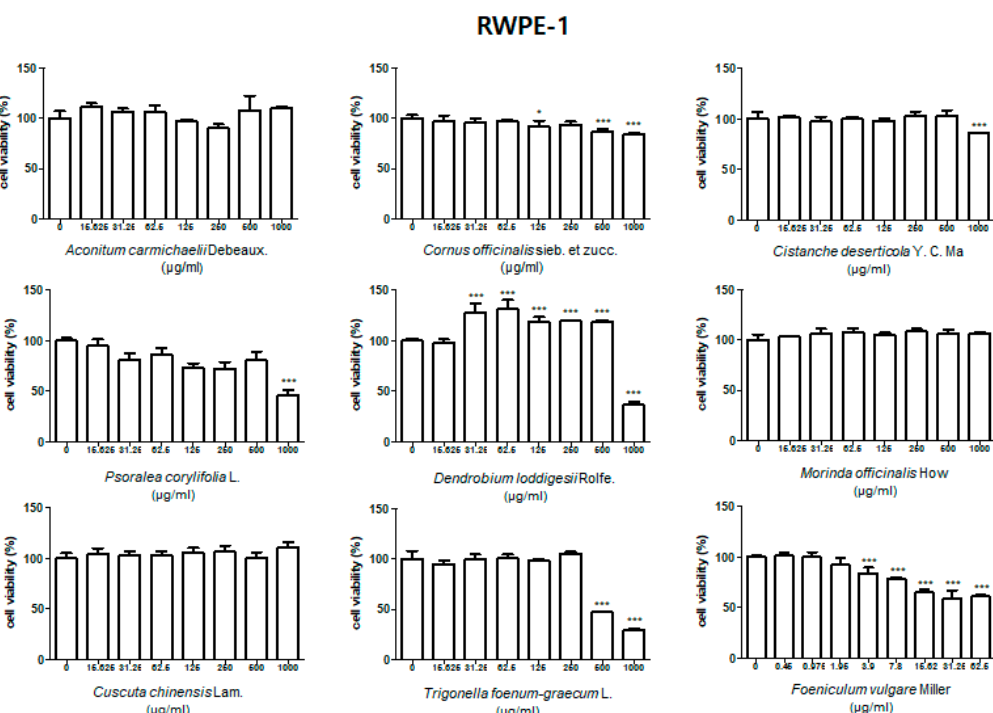
Figure 1. Effect nine herbs of HBX-5 on the cell viability in RWPE-1 cells. RWPE-1 cells were treated with 0.25–1000 μ g/mL of HBX-5 components for 24 h. Values of cell viability were analyzed by ANOVA and Dunnett’s post hoc test for significances between each experimental group and resented as mean ± S.D. of three independent experiments (* p < 0.05, *** p < 0.001 versus untreated control group).